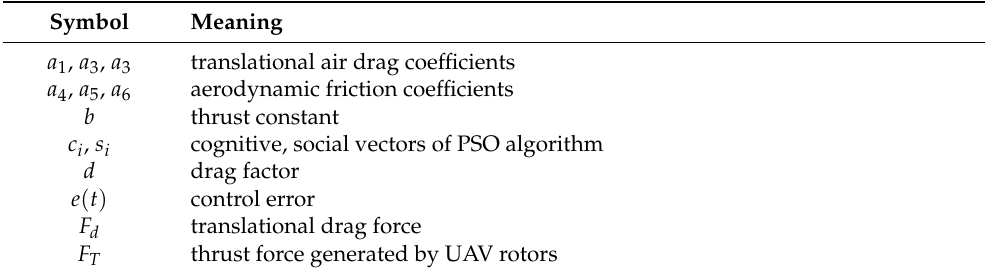
Table 1. Meaning of symbols used in the